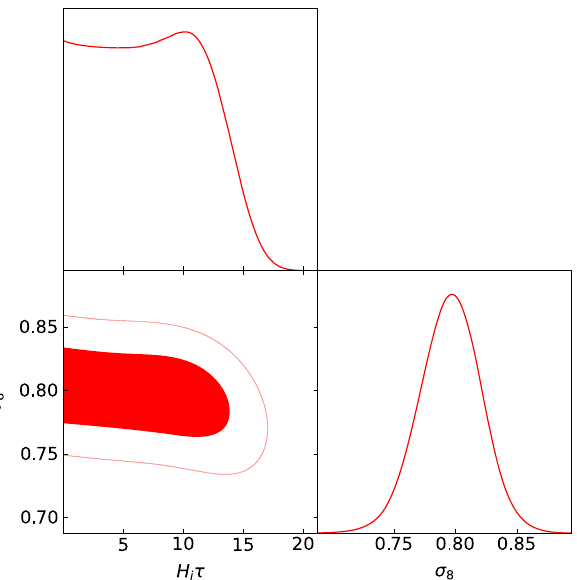
Fig. 15 Marginalized posterior distributions of the time delay param- eter τ and σ 8 using the f σ 8 ( z ) data alone. The median estimates are